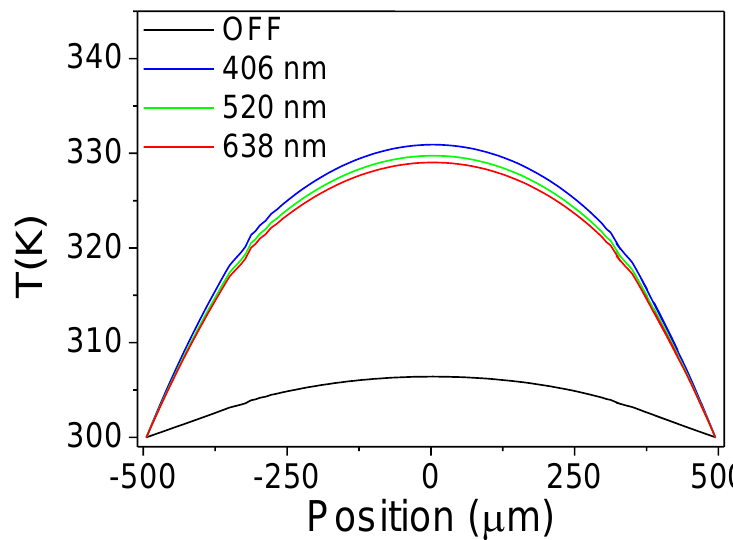
Figure 2. Temperature as a function of the position from the center of the device simulated by finite element modeling (FEM).